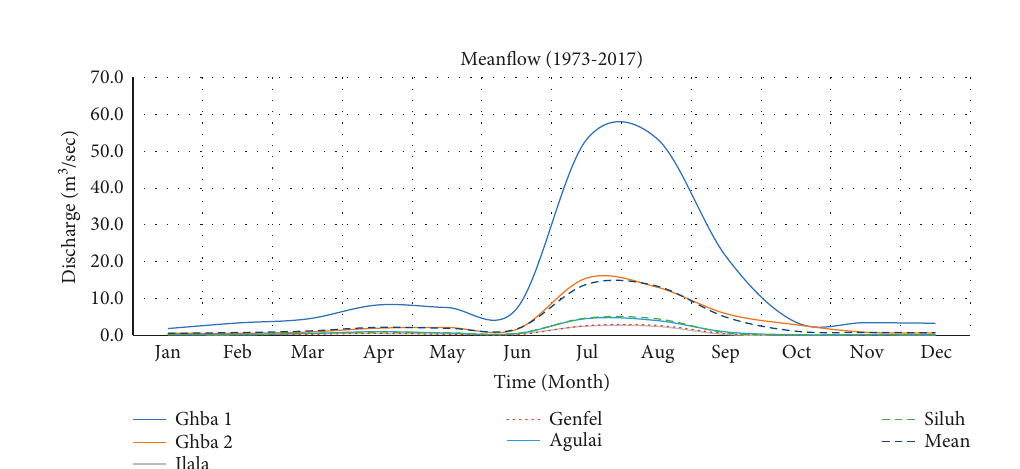
Figure 6: The annual standardized anomaly index (SAI) of rainfall stations in the subbasin.